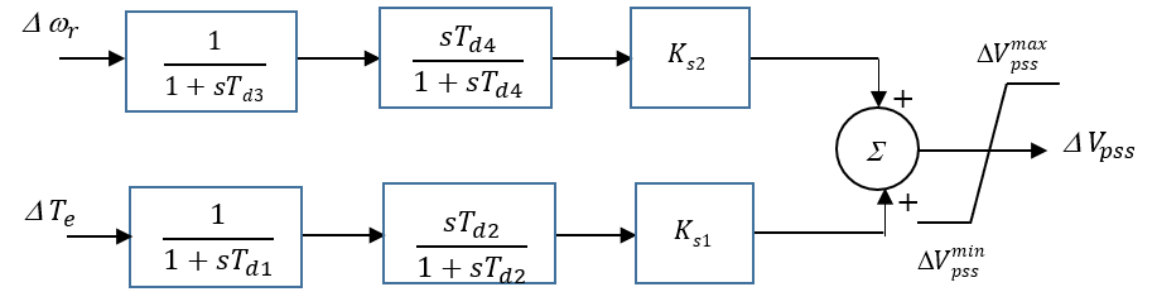
Figure 3. DIPSS block diagram.